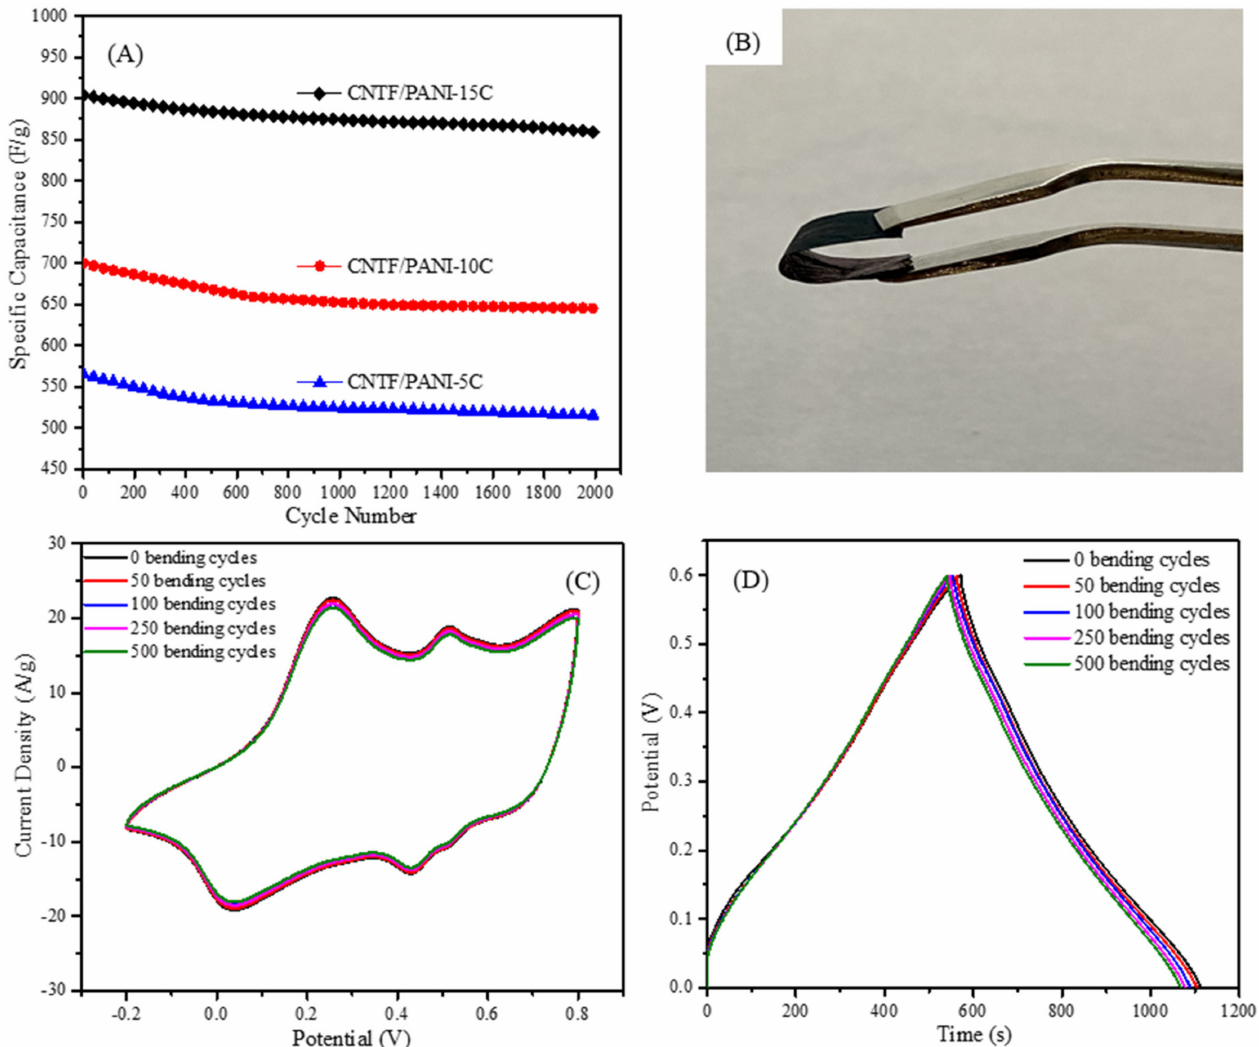
Figure 10. ( A ) The cycling performance of CNTF/PANI-5C, CNTF/PANI-10C and CNTF/PANI- 15C nanocomposite electrodes at a current density of 1 A/g in 1.0-M H 2 SO 4 solution; ( B ) Image of CNTF/PANI-15C nanocomposite electrodes bent to 180 ◦ ; ( C ) CV curves of CNTF/PANI-15C electrode after different bending cycles; ( D ) GCD curves of CNTF/PANI-15C electrode after different bending